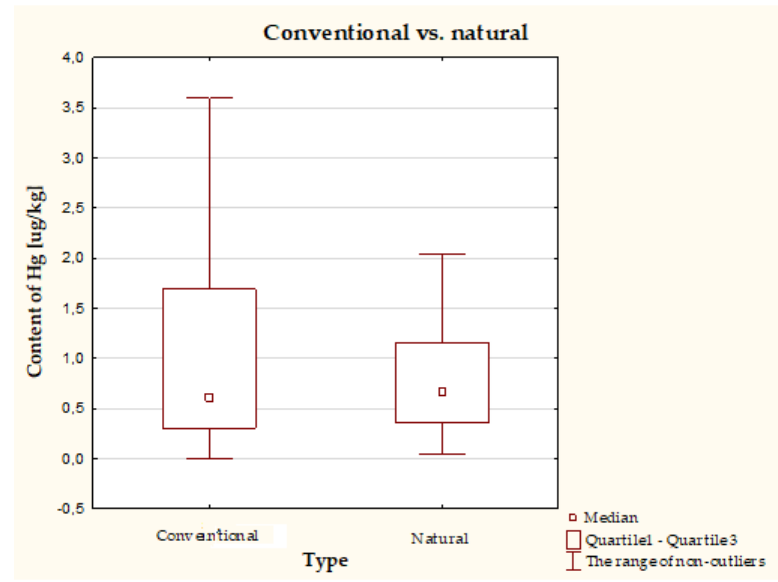
Figure 2. Concentration of Hg in conventional ( n = 181) and natural ( n = 87) cosmetics.